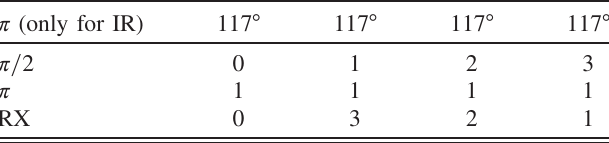
TABLE III. Phase of pulses for SE and